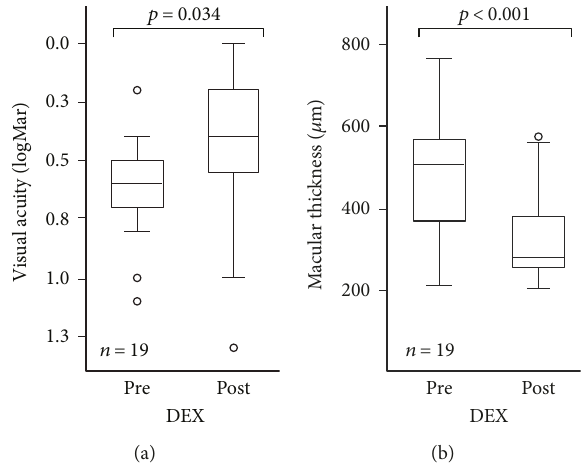
Figure 1: Visual acuity and macular thickness prior to and post DEX implantation. (a) The box plot shows median visual acuity in logMAR (vertical line in the column), 95% con fi dence interval (column), and the standard deviation (extension lines) before and after treatment with DEX implantation. Statistical analysis with ANOVA followed by a Tukey post hoc test demonstrated a statistically signi fi cant increase of visual acuity after treatment with a DEX implant ( p = 0 034 ). (b) The box plot shows mean central foveal thickness in μ m (vertical line in the column), 95% con fi dence interval (column), and the standard deviation (extension lines) before and after treatment with DEX implantation. Statistical analysis with ANOVA followed by Tukey post hoc test demonstrated a statistically signi fi cant decrease of central foveal thickness after treatment with a DEX implant ( p < 0 001 ). ° symbolizes single values with a 1.5- to 3-fold interquartile range distance to the